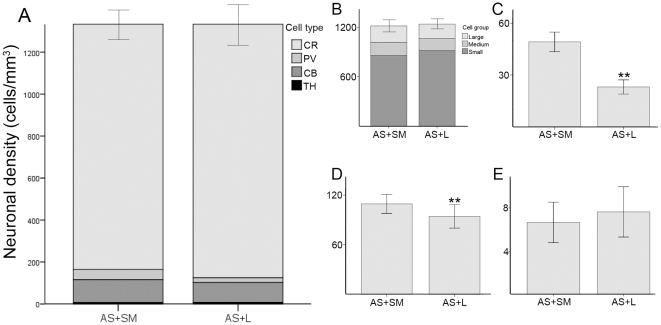
Mean neuronal density in the striatal territories with overlapped projections.A, stack bar graph showing the global interneuronal density (cells/mm3). The stacks indicate different groups of neurons. B, stack bar showing the density of CR-ir interneurons (cells/mm3) and their morphological subgroups. C–E, neuronal density of the PV-, CB- and TH-ir neurons, respectively (cells/mm3). Error bars indicate the SEM. **, P<0.01. AS+L, associative+limbic; AS+SM, associative+sensorimotor.